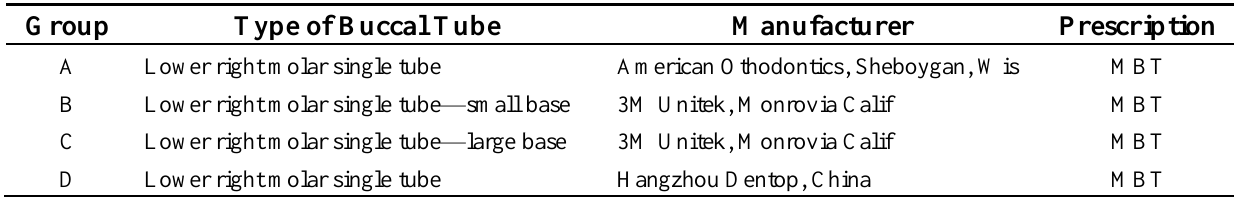
Table 1 . Types of buccal tubes from various